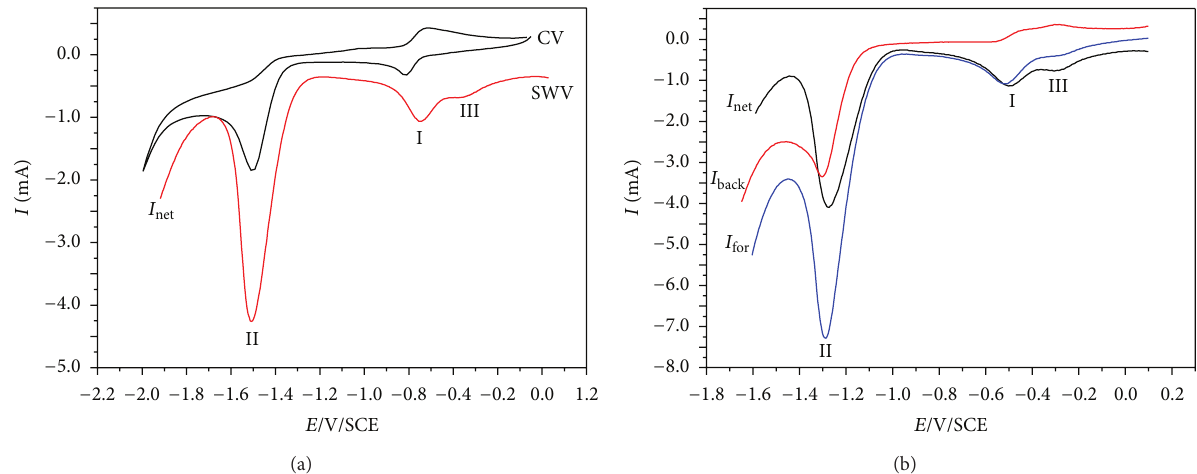
Figure 5: (a) Comparison of typical CV and SW voltammograms of 20 mM of BP recorded in NB membrane in contact with an aqueous phase consisting of a buffer at pH 1 and (b) Net SW voltammograms recorded with a the thinfilm electrode in contact with aqueous medium at pH = 1. For CV, the sweep rate is V = 20 mV ⋅ s −1 , and for SWV the frequency is 𝑓 = 12 Hz, SW amplitude 𝐸 dE = 1mV.